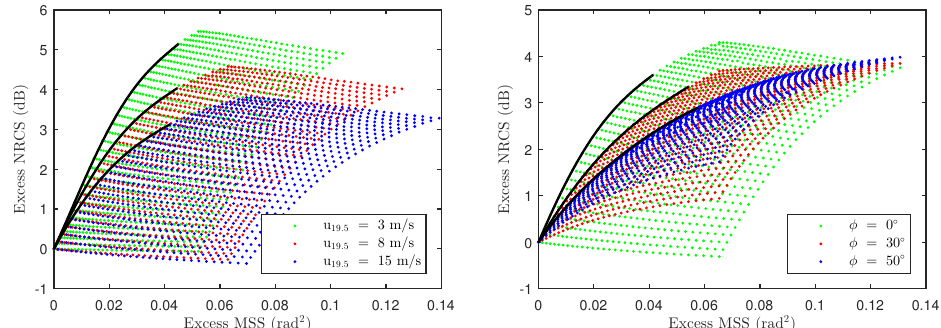
Figure 19. The distribution of excess MSS and NRCS versus wind speed (at φ = 0 ◦ ) and relative azimuth (at u 10 = 10 m/s) are shown in ( left ) and ( right ) plots, respectively. The leading edge of each surface, approximated using 4th-degree polynomial, is indicated using black